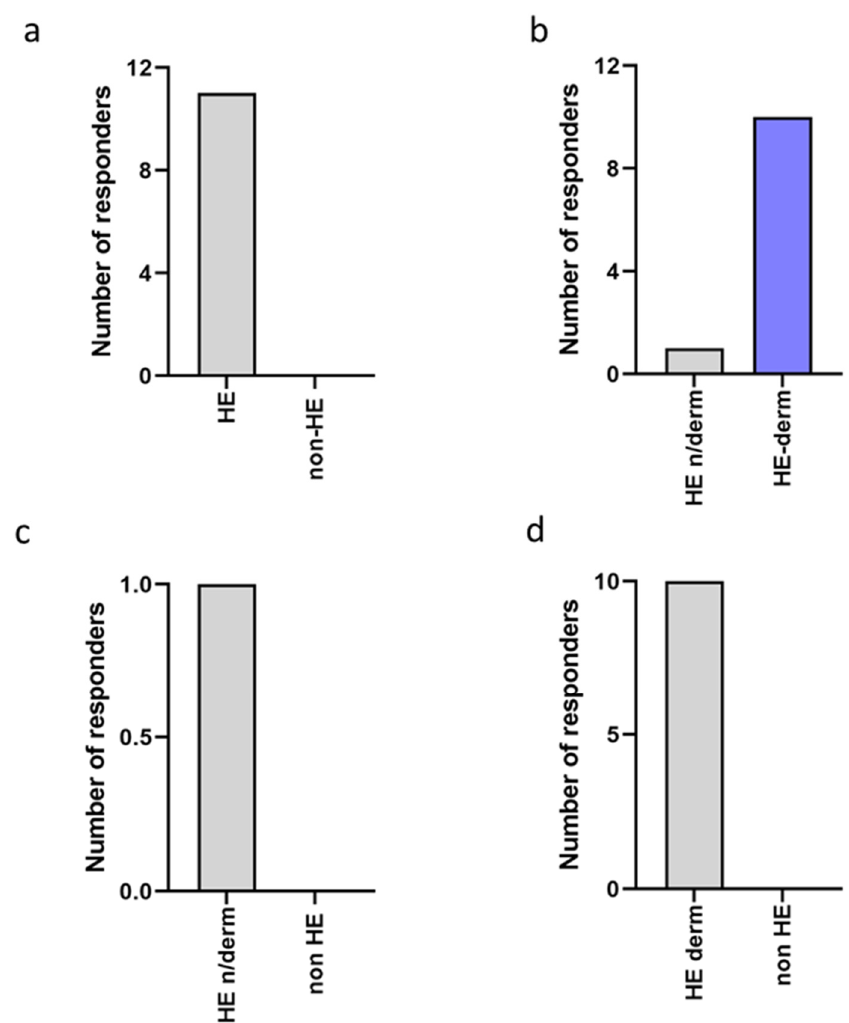
Figure 7. Comparison of the frequency of edema reported in the study groups: ( a ) non-HE vs. HE; ( b ) HE n/derm vs. HE-derm; ( c ) non-HE vs. HE n/derm; ( d ) non-HE vs. HE-derm.